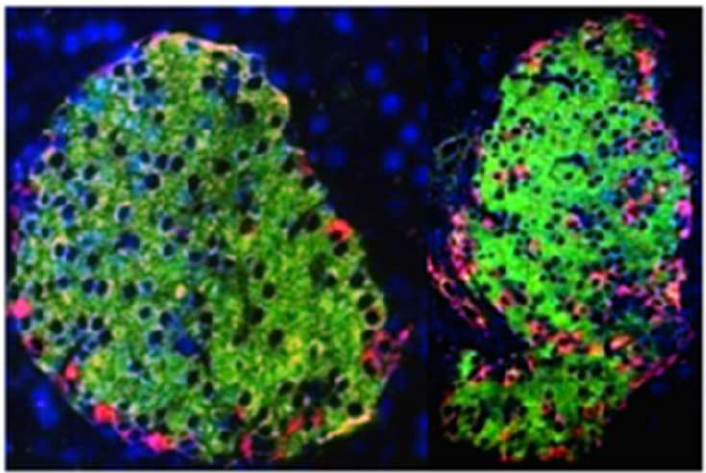
Figure 5. Intrusion of pancreas α -cells into the β cell interior of mouse islets during vitamin A disruption . Left, WT islets; right, Rbp1 -null islets. Red indicates glucagon-secreting α cells. Green indicates insulin-secreting β cells. This phenomenon occurs in the Rbp1 -null mouse and in the Lrat -null mouse [61,62].